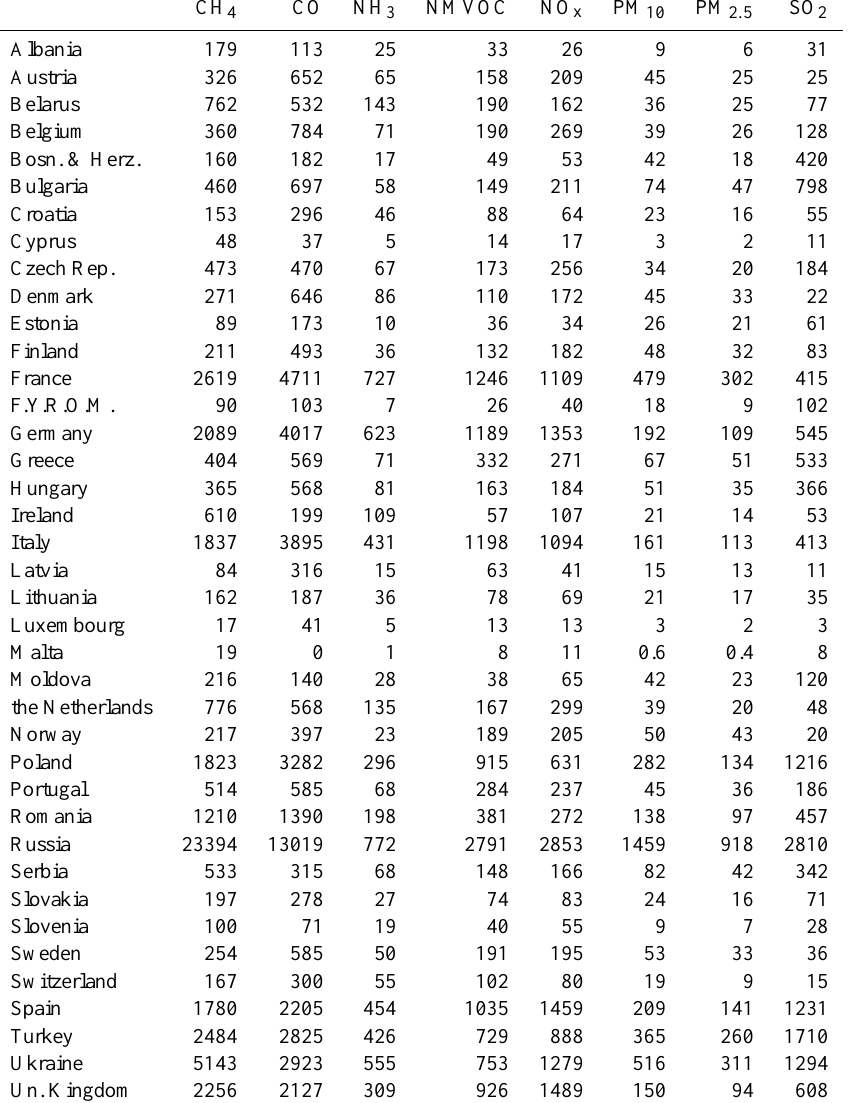
Table 1. Anthropogenic emissions (ktyr − 1